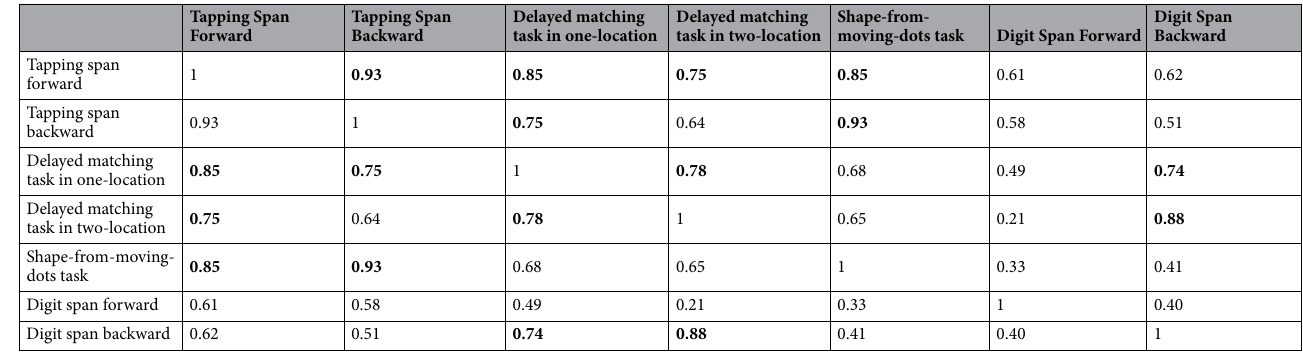
Table 4. Pearson’s correlation coefficient between tapping span and spatial working memory tests and between tapping span and digit span for the posterior cortical atrophy group. Bold values represent those with P-values of <